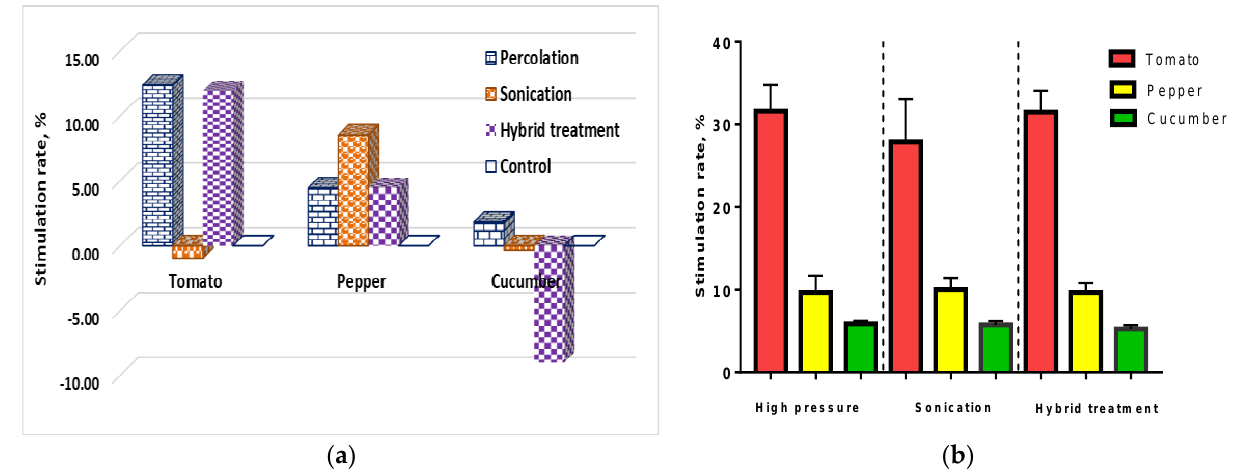
Figure 11. The influence of the obtained solutions on the tomato, pepper, and cucumber leguminous crops, in terms of seedling biostimulation: ( a ) stimulation rate measured according to the percentage of developed leaves (after 10 days) and ( b ) comparative evaluation of the extracts’ impact on seedlings (median and standard deviation statistical processing).